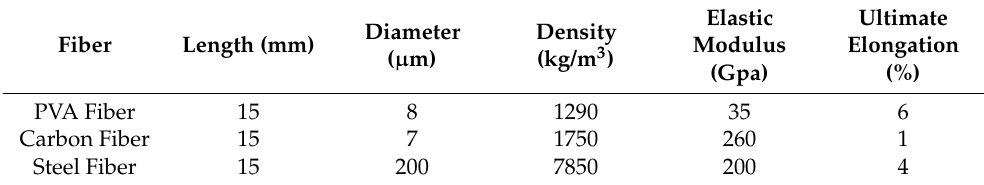
Table 2. Fiber specifications.